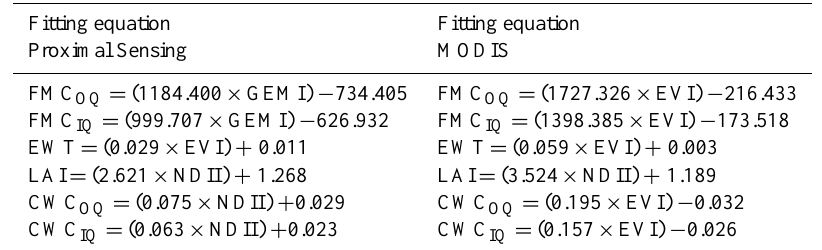
Table 2. Empirical fitting equations obtained after bootstrap.